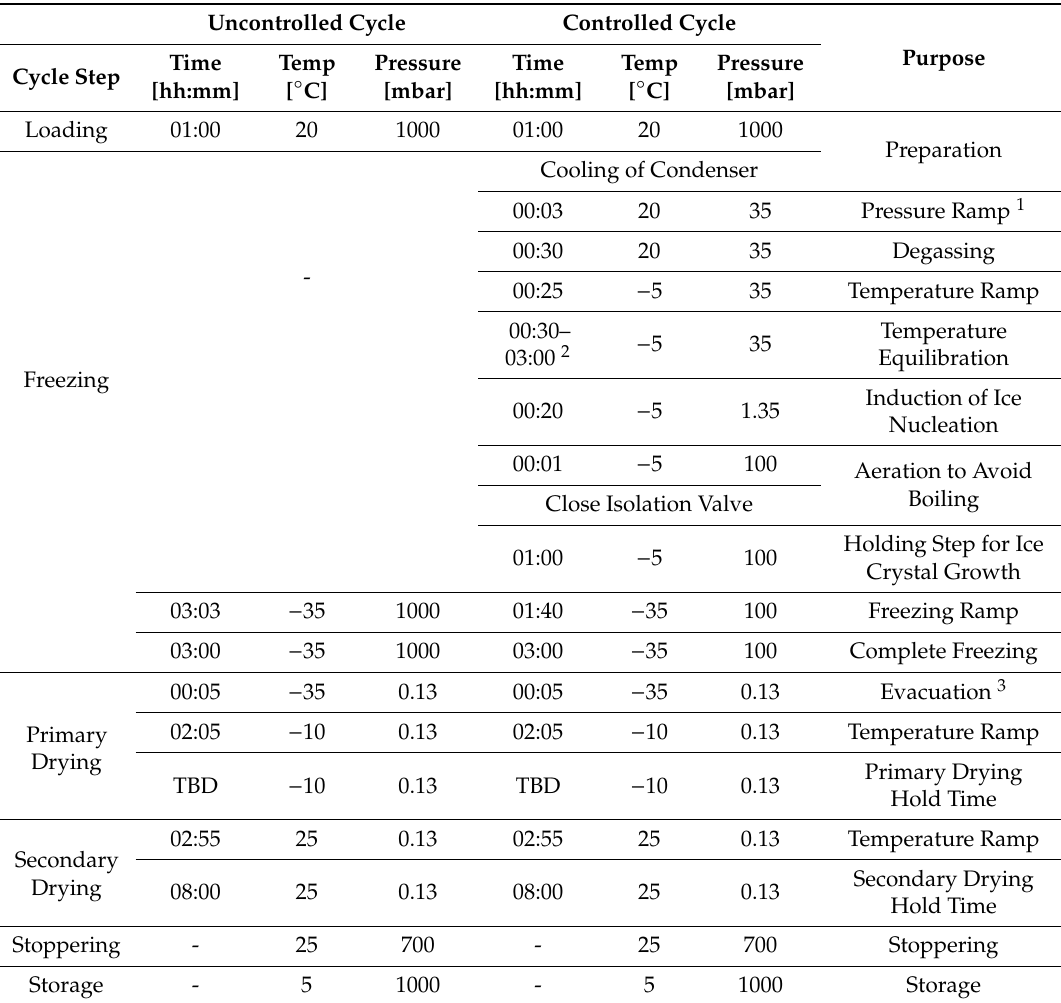
Table 1. Freeze-drying parameters for uncontrolled and controlled nucleation runs with optimized